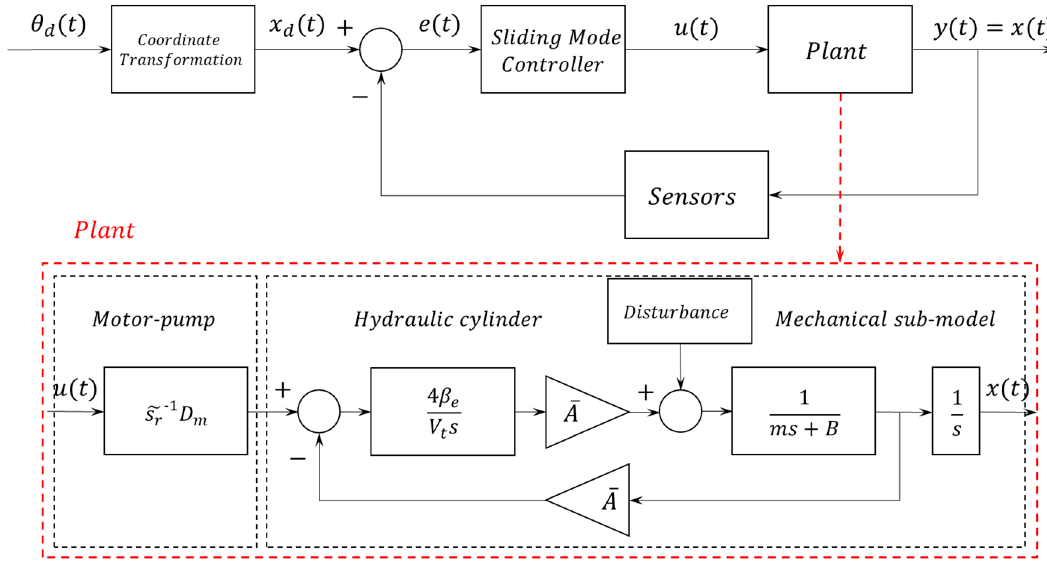
Figure 8. Sliding mode control scheme.